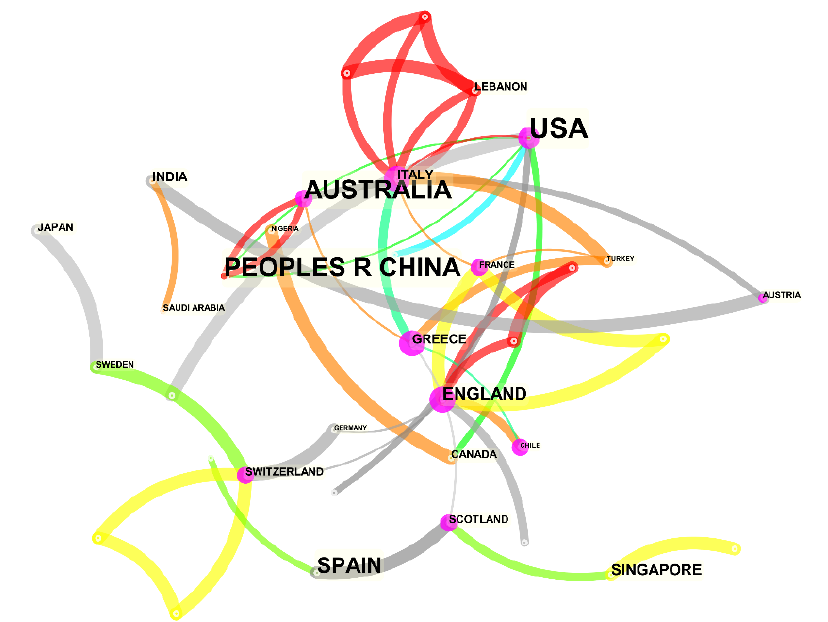
Figure 2. Country cooperation. Table 1. Statistics of national cooperative publishing (Top 10).